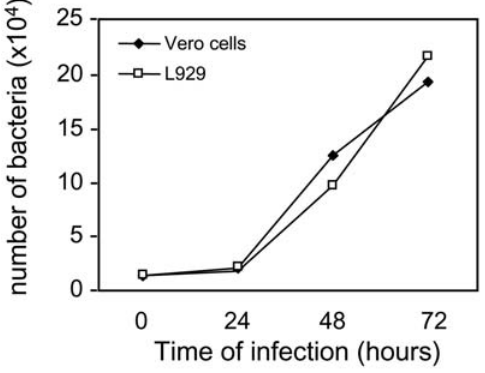
Figure 5. Intracellular growth of R.raoultii . Bacterial growth was evaluated by qRT-PCR as described in the Materials and Methods, using either L929 cells (black circles) or Vero cells (white circles). Eukaryotic cells approaching confluence and grown in shell vials were infected with 1.5 6 10 4 bacteria. Each point corresponds to the mean of two distinct